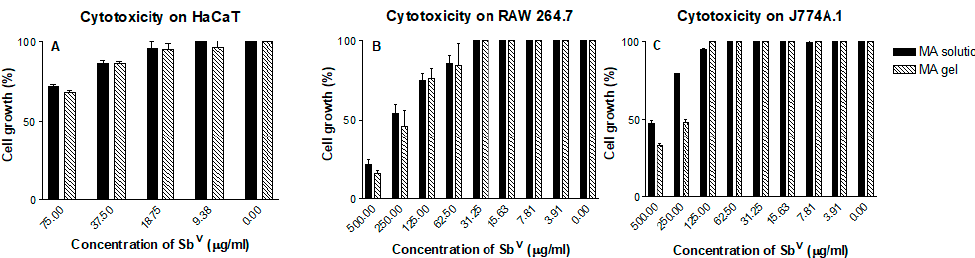
Figure 8. Cytotoxicity of the gelling excipients in cell lines ( A ) HaCaT, ( B ) RAW 264.7 and ( C ) J774A.1.